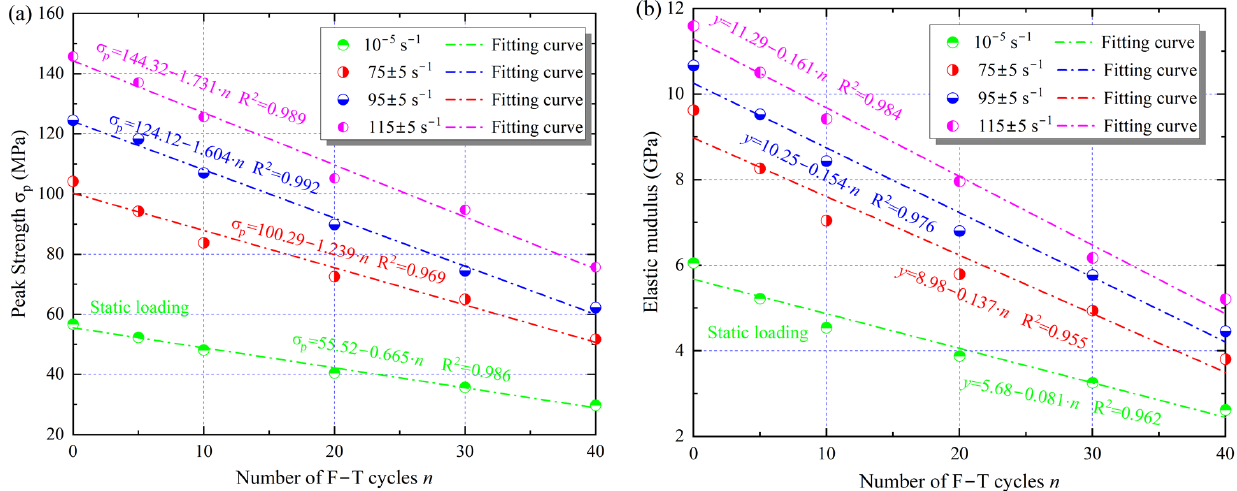
Figure 14. Variations of peak strength ( a ) and elastic modulus ( b ) of samples with cyclic F–T action.